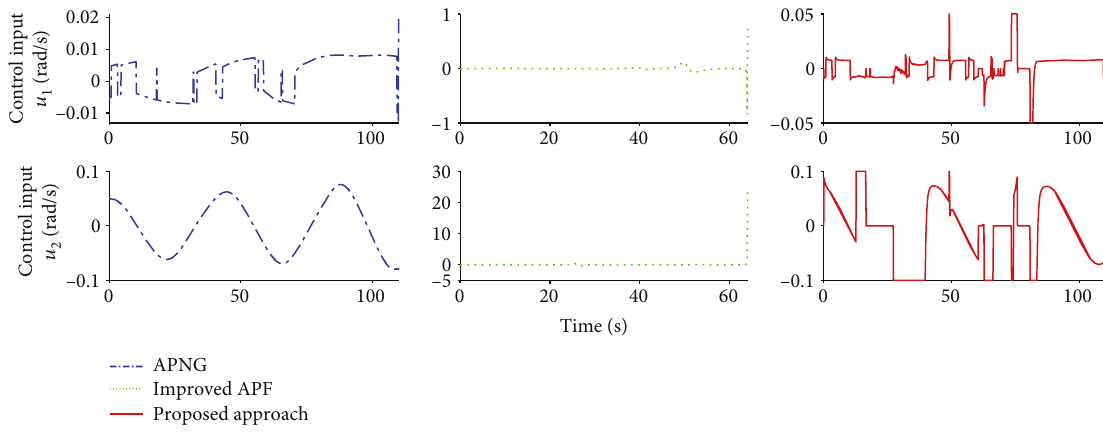
Figure 26: Changes of control inputs in case